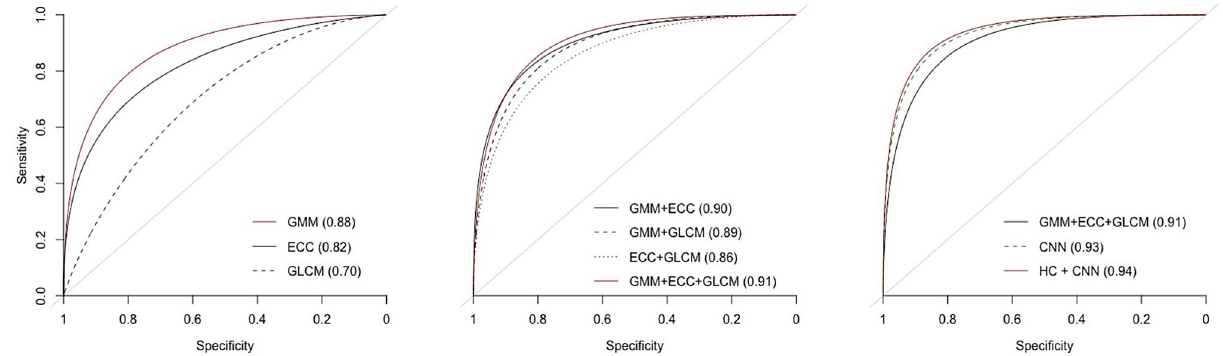
Figure 6. ROC curve and AUC value of testing data incorporating different combination of feature inputs trained with full-size training data.